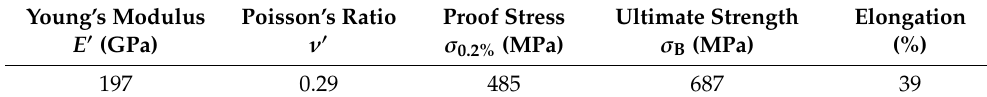
Table 2. Mechanical properties of cast duplex stainless steel ASTM A890 Gr.3A.